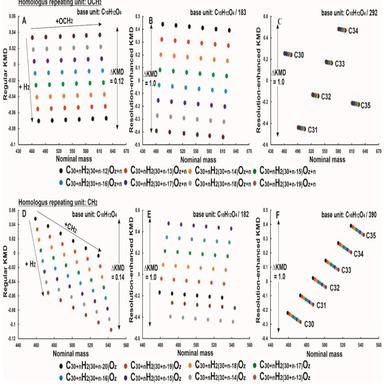
KMD plots for simulated oligomeric structures with homologous repeating units OCH2 (A–C) and CH2 (D-F), and C10H12O4/X Kendrick base unit with X = 1 (A, D), 183 (B), 292 (C), 182 (E), and 390 (F).